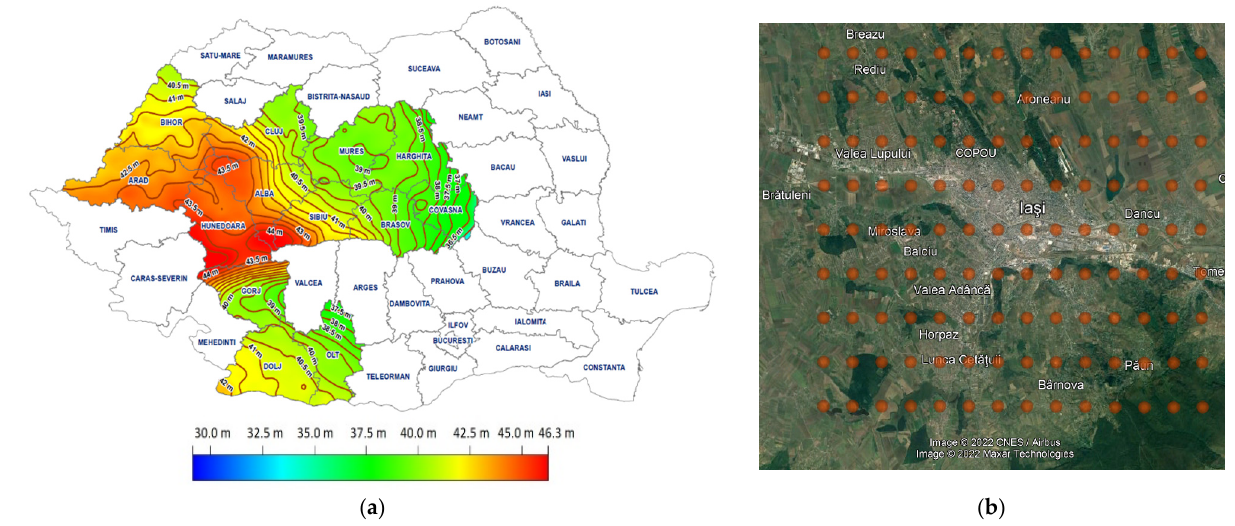
Figure 1. ( a ) Gravimetric quasigeoid for the Romanian territory; ( b ) EGG2008 grid extracted for the Iasi city study area.